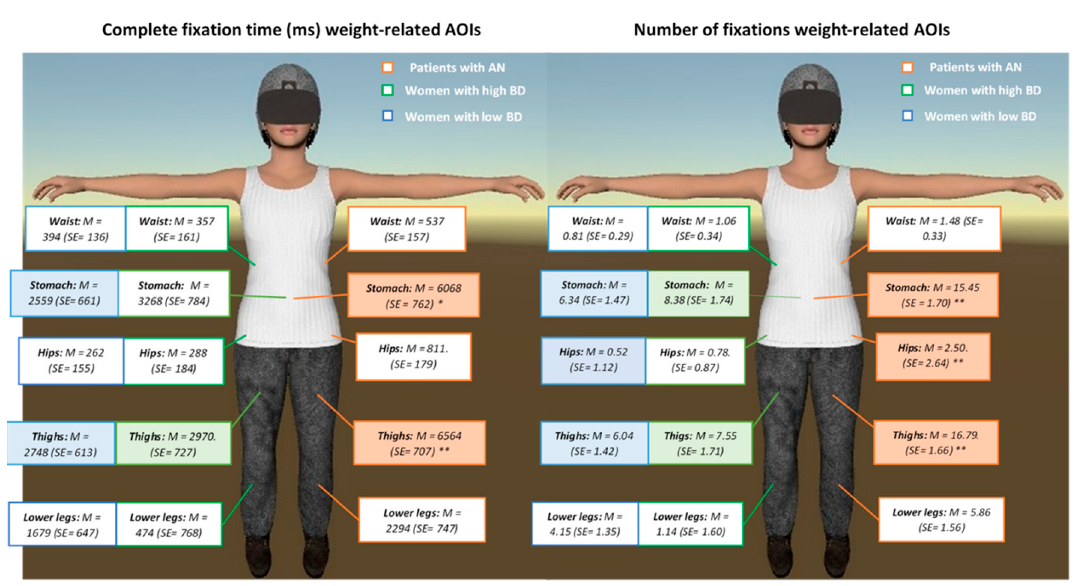
Figure 2. Differences between patients with Anorexia Nervosa (AN) and women with high and low body dissatisfaction (BD) (means and standard errors) in the complete fixation time (in milliseconds; ms) and the number of fixations on individual weight-related areas of interest (AOIs). Post-hoc analyses: ** p < 0.01 and * p < 0.05.